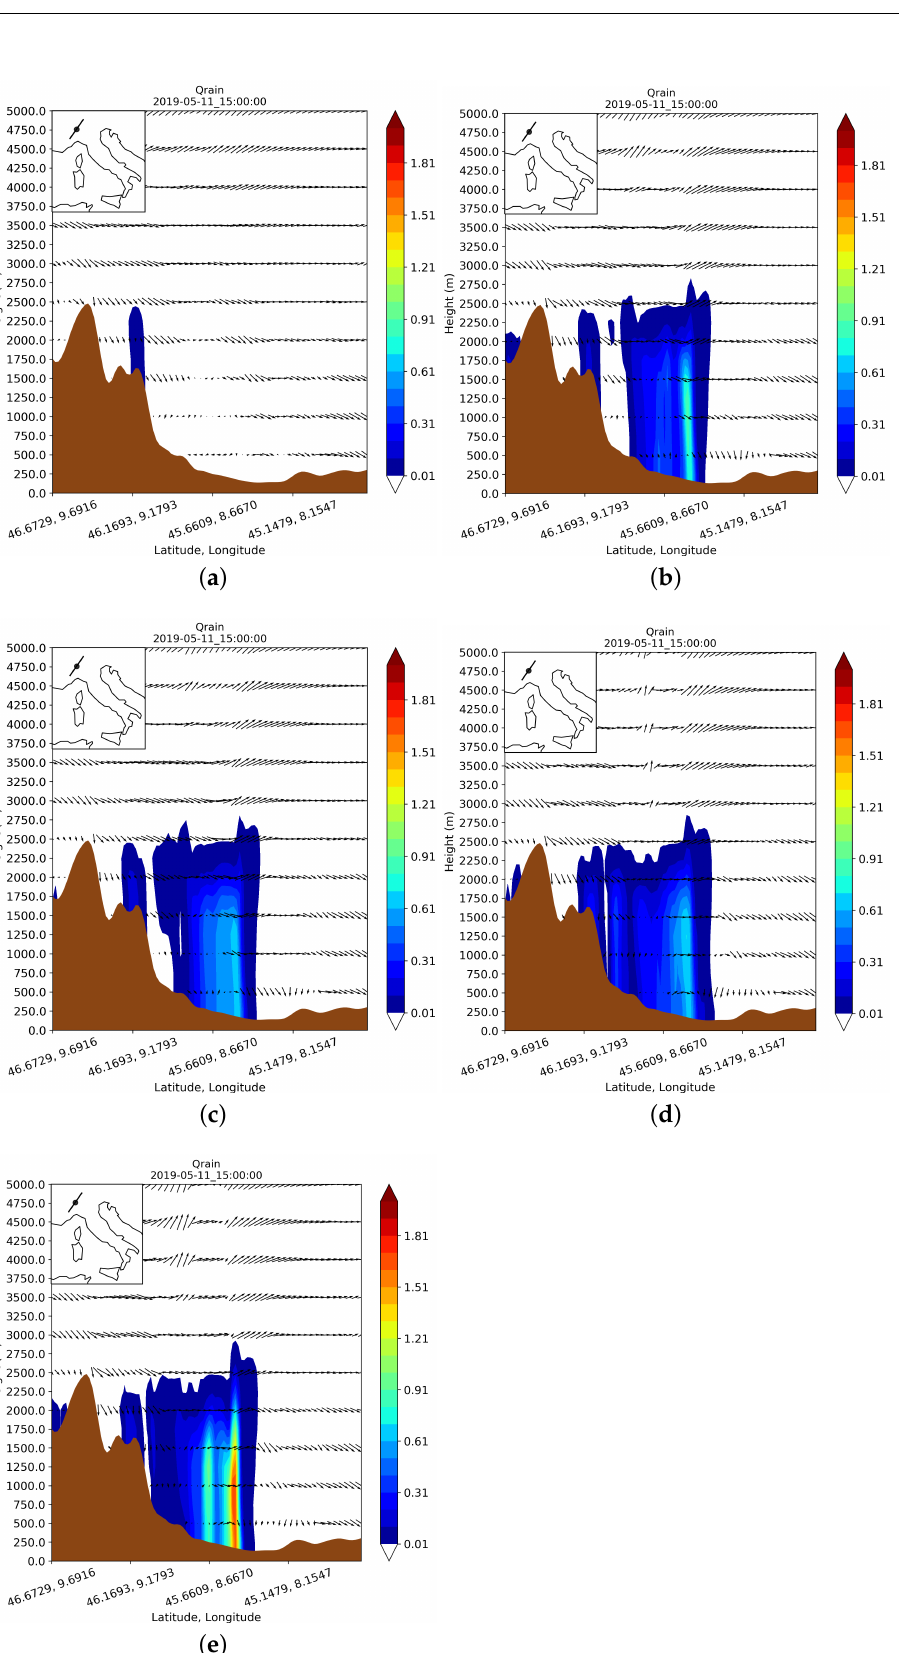
Figure 9. Vertical cross-sections of rainwater mixing ratio (qrain, g kg − 1 ) through the squall line for the CTL ( a ), RDR-LIG ( b ), RDR-ZTD-LIG ( c ), RDR-TMP-LIG ( d ) and ALL ( e ) simulations at 15:00 UTC, 5 May